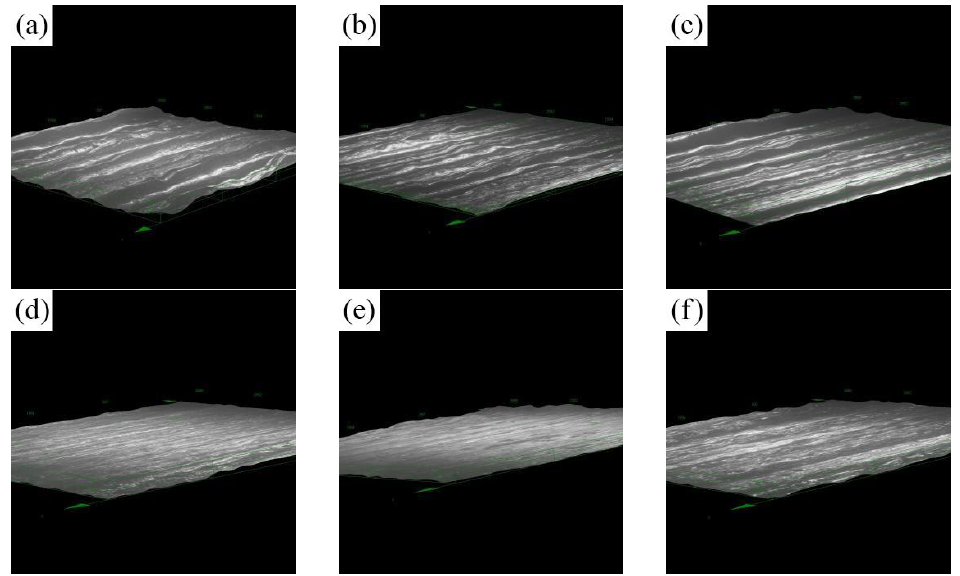
Figure 6. Three-dimensional surface morphology of aluminum bronze ( a – c ) and aluminum bronze-based ISSLB materials ( d – f ) (69 times), ( a , d ) 100 N, ( b , e ) 300 N, ( c , f ) 500 N.